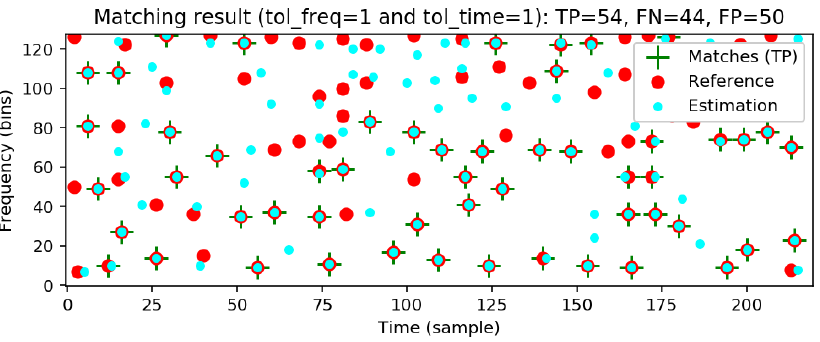
Figure 18. Evaluation measures that indicate the agreement between two constellation maps com- puted for an original version (Reference) and a noisy version